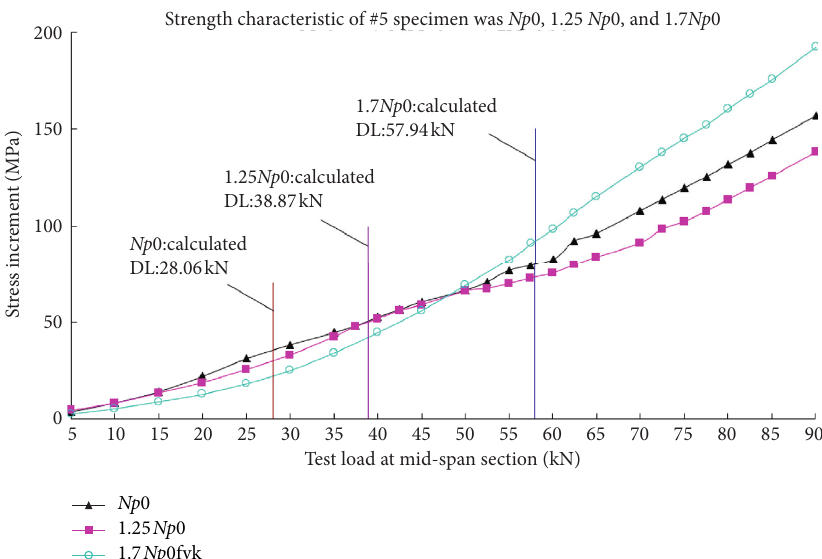
Figure 6: Stress increment vs. load curve by the traditional method (by test data).